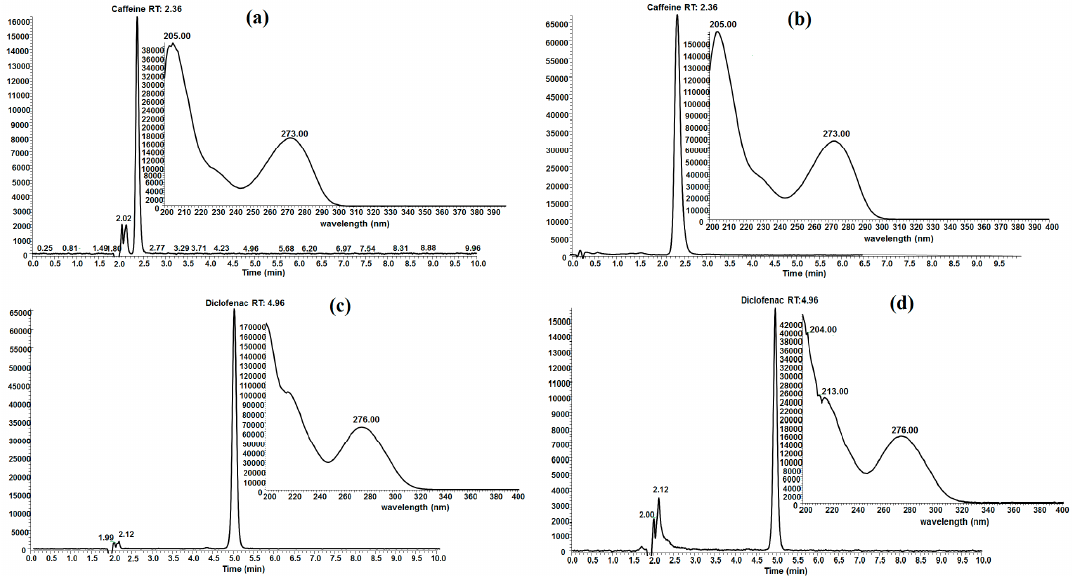
Figure 7. HPLC chromatogram and UV spectrum of caffeine ( a ), FB850-3+CFN ( b ), diclofenac ( c ) FB850-3+DCF ( d